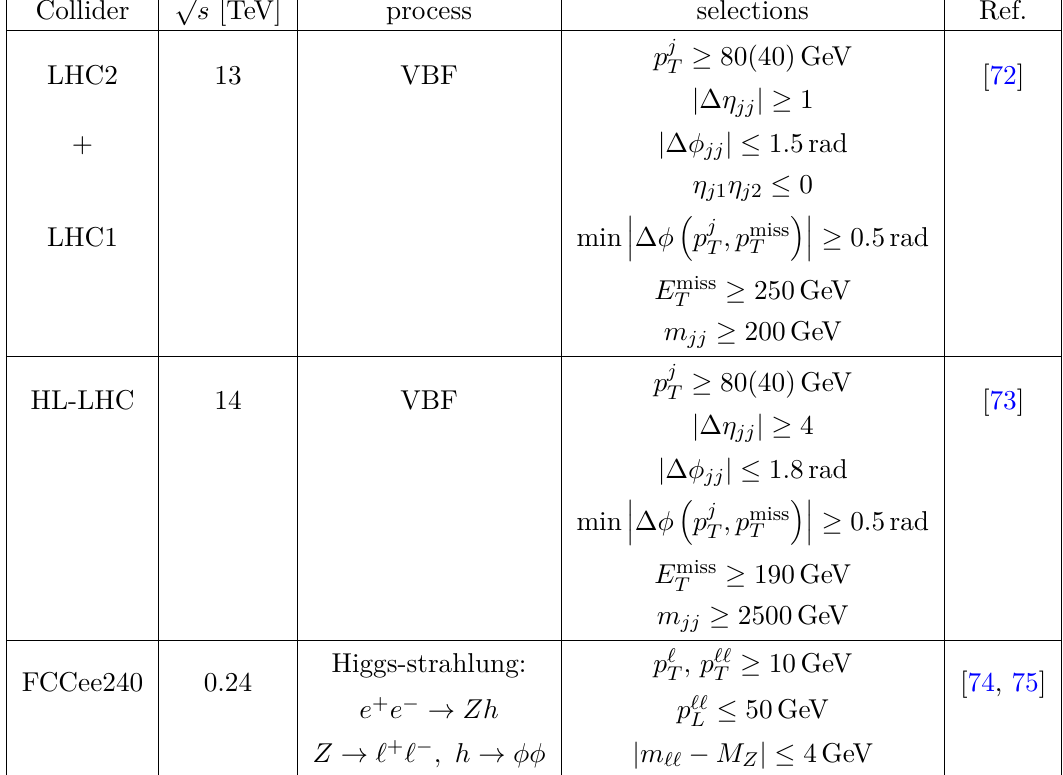
Table 2 . Analyses of invisible Higgs decays recast in this work to constrain the scalar singlet. √ Collider s [TeV] process selections Ref.